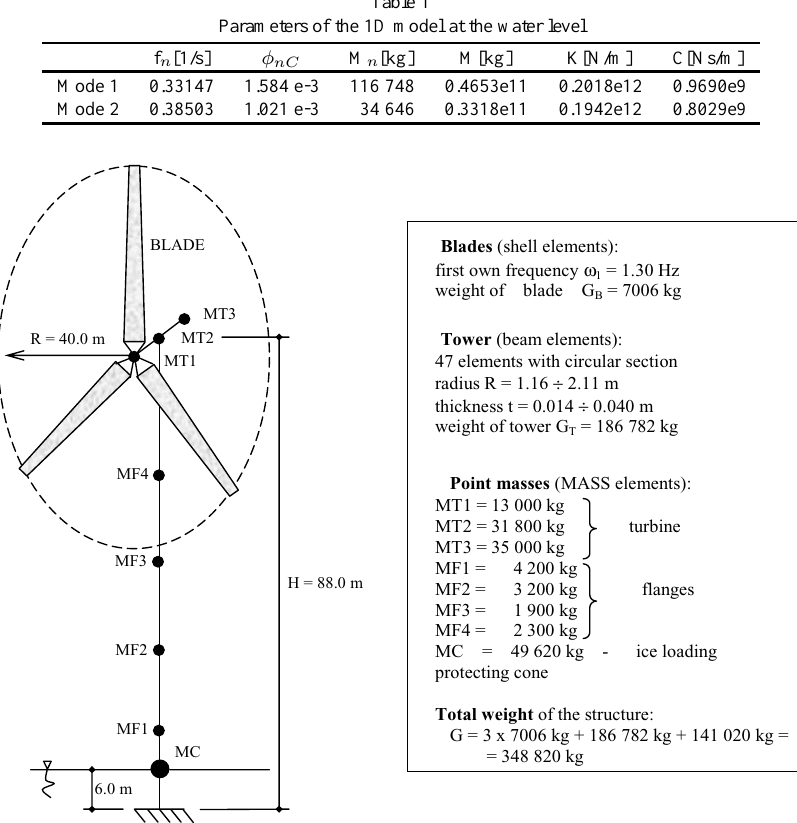
Fig. 3. Numerical model of the wind turbine tower by A. Mr´oz